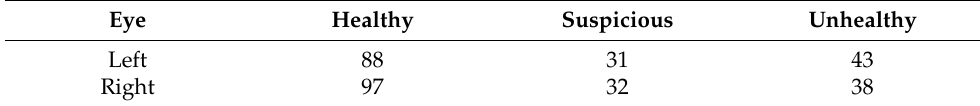
Table 1. Content of the OCT dataset used to validate the approach.